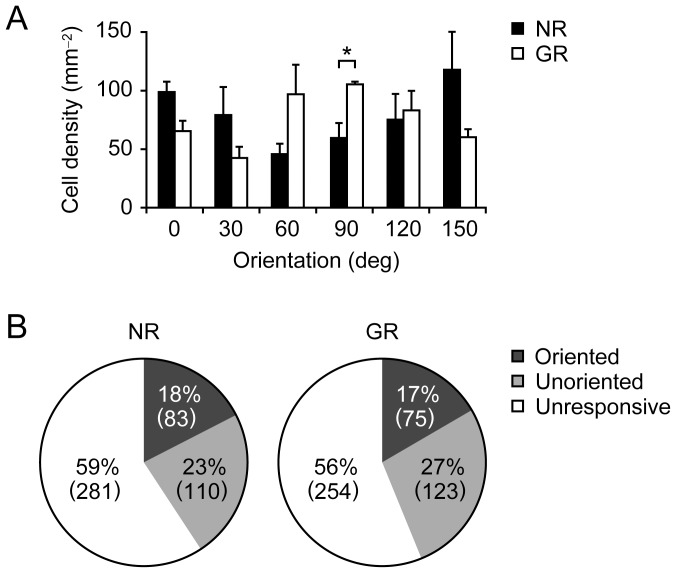
Neuron densities and abundance ratios of oriented and unoriented neurons.(A) Histograms of neuron density for NR and GR mice. The difference in the neuron density between NR and GR mice was statistically significant for the vertical orientation (p<0.05, Student t-test). Error bars indicate SE. (B) Ratios of the numbers of oriented, unoriented and unresponsive neurons to the total number of neurons identified by OGB-1 signals for the NR group (left) and GR group (right). The absolute numbers of respective types of neurons are shown in parentheses. The abundance ratio of oriented neurons as well as that of unoriented neurons did not differ between the two groups.